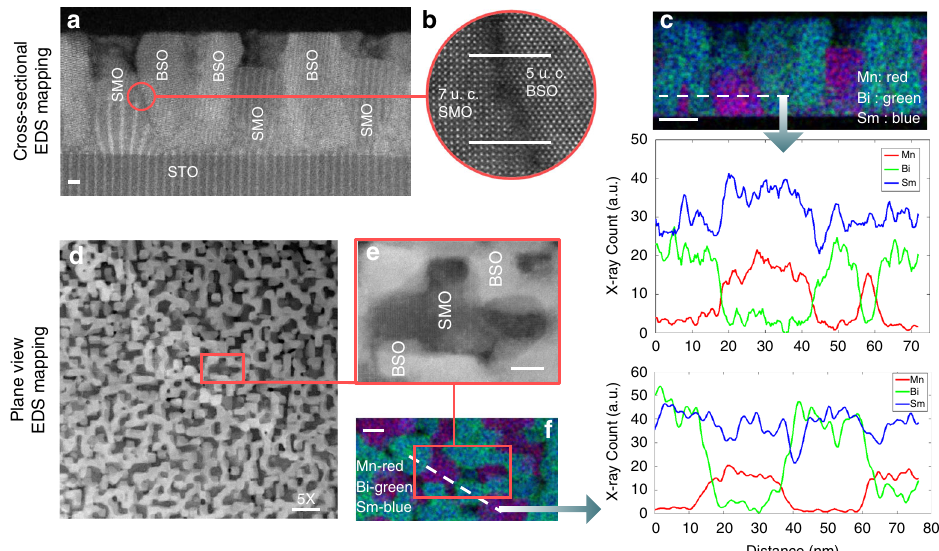
Fig. 1 Electron microscopy images of thick SMO:BSO VAN fi lm grown on STO (001). a Cross-sectional STEM-HAADF image showing clear pillars of BSO embedded in SMO. The BSO grows faster than SMO as observed by the pillars being thicker than the SMO. b BSO and SMO showing domain matching epitaxy of 7 unit cells of SMO matching with 5 unit cells of BSO. d Plan-view STEM-HAADF image shows a VAN structure over a wide area. A regular pattern of connected BSO pillars in an SMO matrix is observed. e A region of SMO enclosed by laterally connected BSO pillars is shown. c , f EDS maps and line pro fi les of across the VAN fi lm, showing that SMO contains only very minor Bi and that BSO has a ~1:1 Bi:Sm ratio. Scale bar: 10